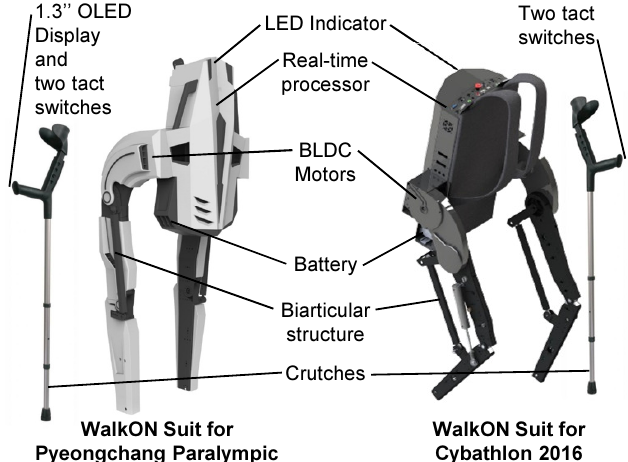
Figure 2. Configuration and comparison of two WalkON Suit systems; the right one was introduced in the Powered Exoskeleton Race of Cybathlon 2016, and the left one was used for the torch relay of the Pyeongchang Paralympics